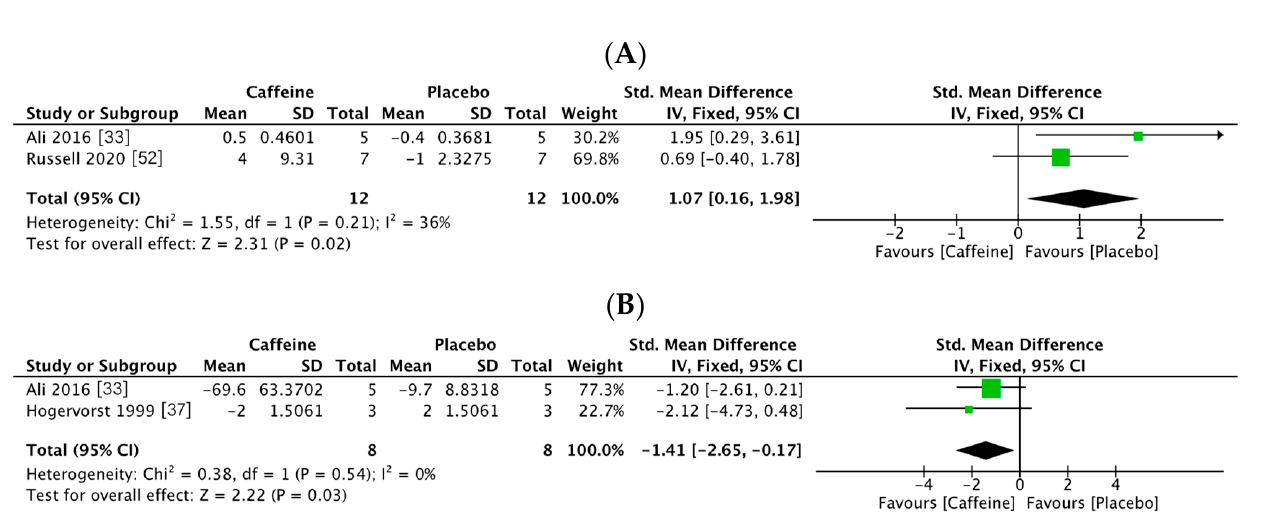
Figure 2. Forest plots of attention performance observed in the athletes in conditions of supplementation with caffeine vs. a placebo. ( A ) Response accuracy; ( B ) response speed.